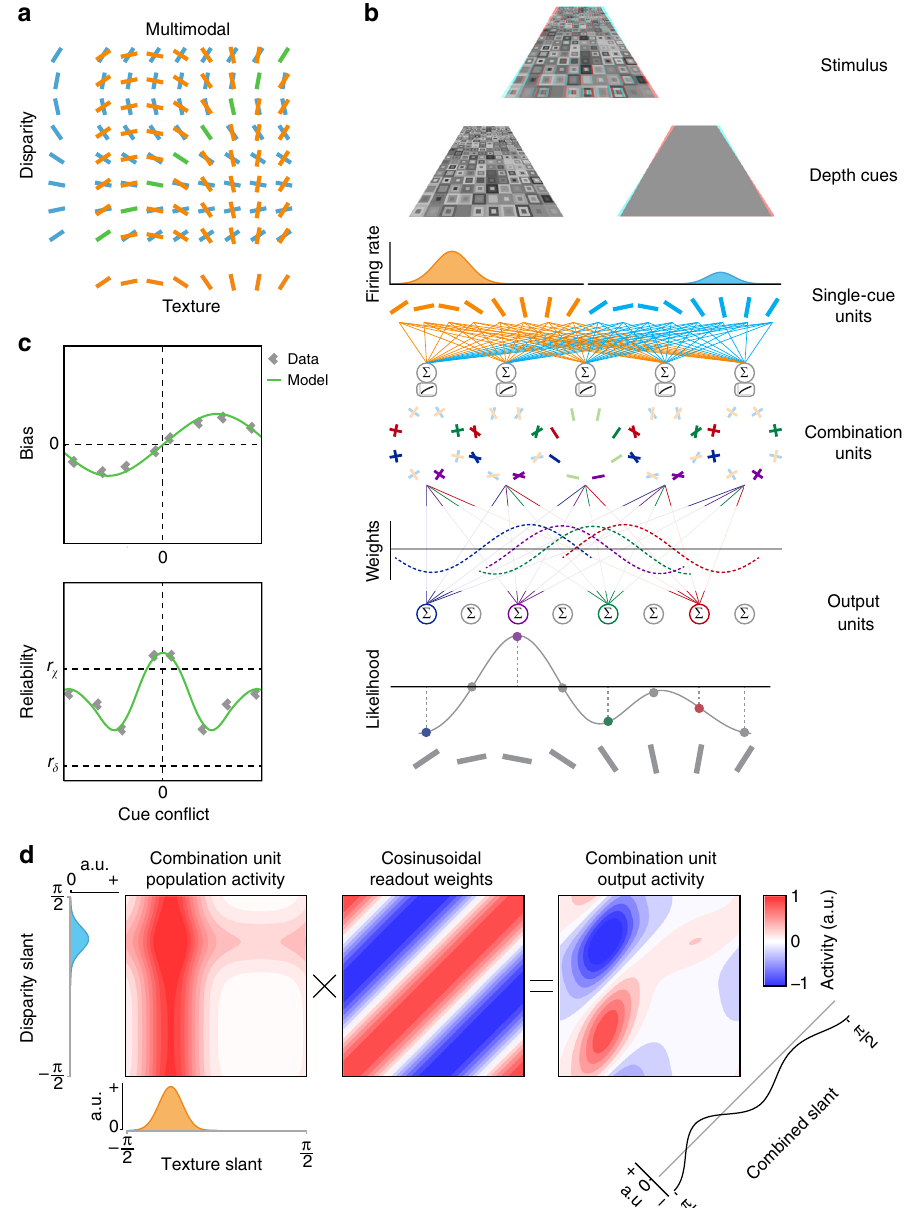
Fig. 2 Schematic illustration of the proscriptive integration model of cue integration. a Cartoon of the network ’ s detectors. The input layer of the model consists of unimodal detectors for slant de fi ned by disparity or texture. These are represented along the ordinate and abscissa. The next layer of the model is the combination units, which are tuned to different combinations of unimodal inputs. b Overview of the model ’ s architecture. A slanted 3D Voronoi stimulus (illustrated for red – cyan anaglyph glasses) activates separate unimodal units tuned to disparity or texture. The response of unimodal units is pooled by combination units. The activity of combination units is then read out according to a cosinusoidal weighting function to produce a likelihood function of slant angle. c Bias and reliability as a function of cue con fl ict, generated by the proscriptive integration model using experimental data from Girshick and Banks 7 . d Example simulation of the model when presented with con fl icting cues. Combination unit activity is equal to the sum of unimodal (texture/disparity) responses. This response is multiplied by a cosine weight matrix, representing readout weights to the output layer. The fi nal estimate is produced by summing